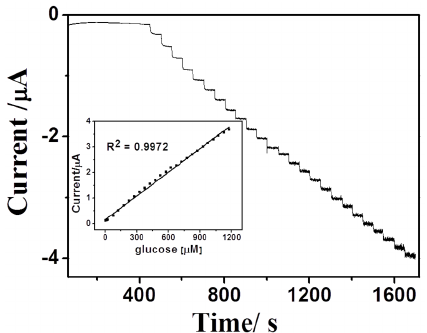
Figure 7. Current-time response of the biosensor upon successive addition of different concentrations of glucose from 5 µM to 1500 µM in 0.01 M PBS (pH 6.0) containing 0.1 M KCl under stirring. The applied potential was − 0.15 V. Inset: the catalytic response vs. glucose concentration.